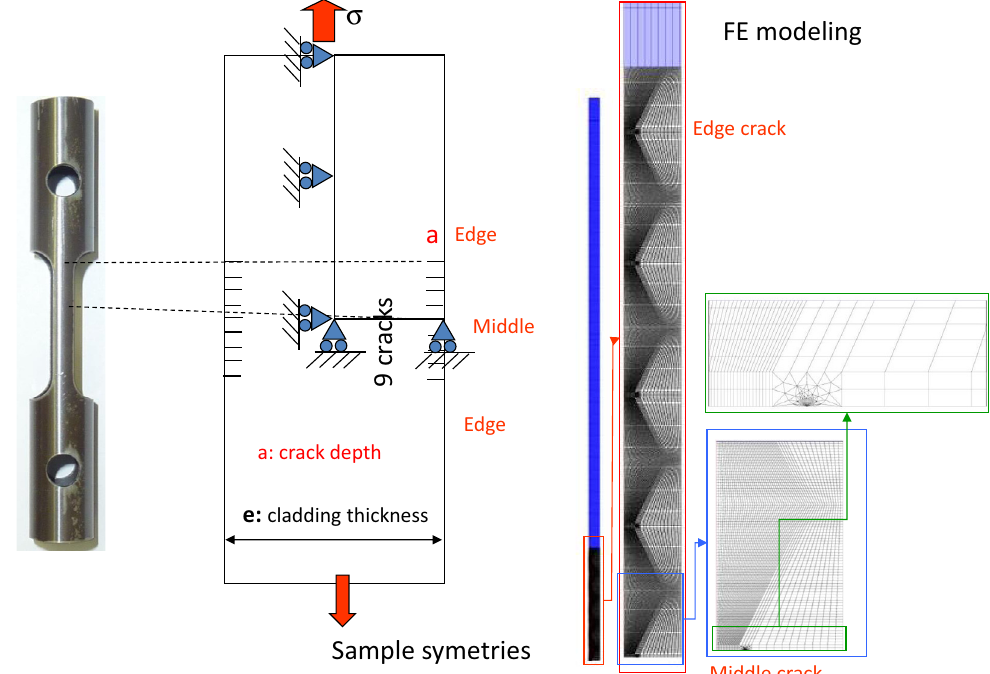
Fig. 6. Periodic crack array modeling to simulate an axial tensile test with multiple crack nucleation at its inner and outer surface.